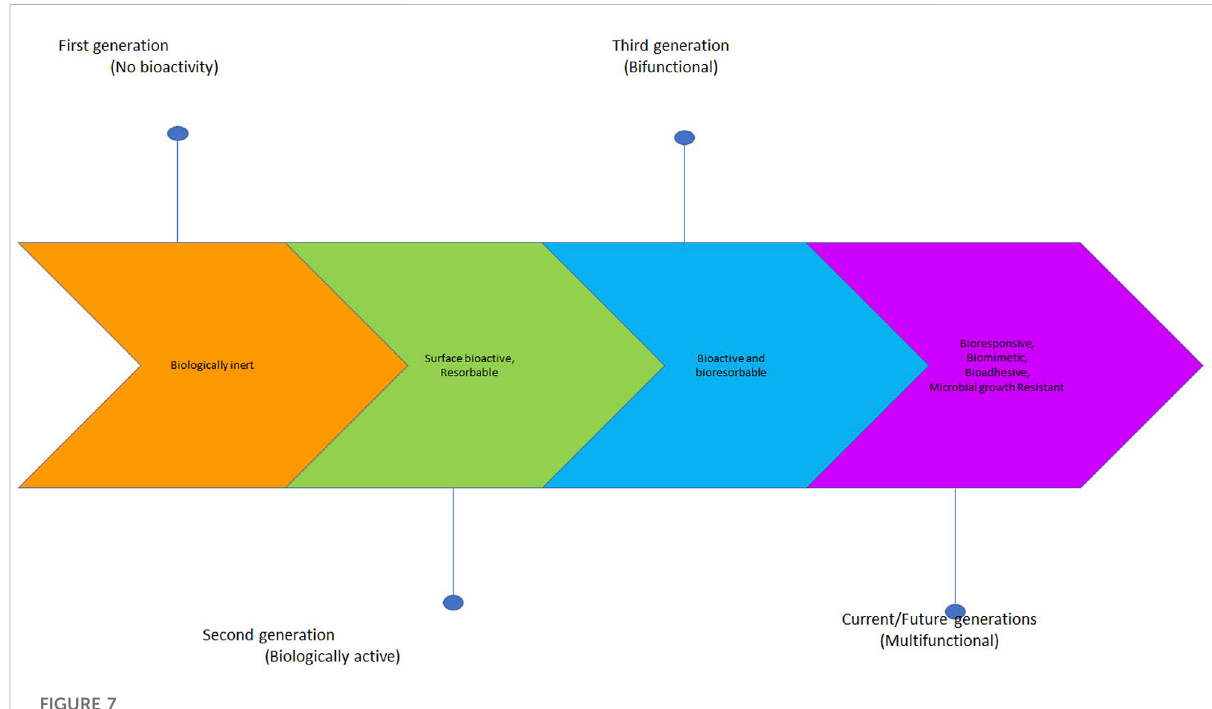
FIGURE 7 The evolving since of bone regeneration